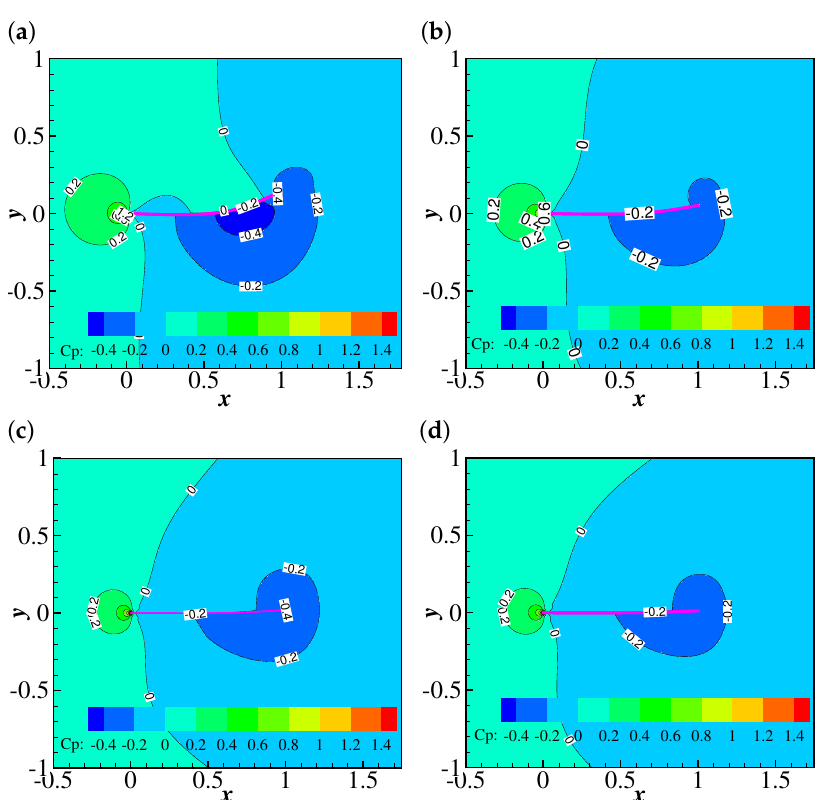
Figure 17. Contours of the pressure coefficient at Re = 100, and Wi = ( a ) 0 (at t = 30.935), ( b ) 0.2 (at t = 30.87), ( c ) 0.6 (at t = 30.825) and ( d ) 1.0 (at t = 30.795).